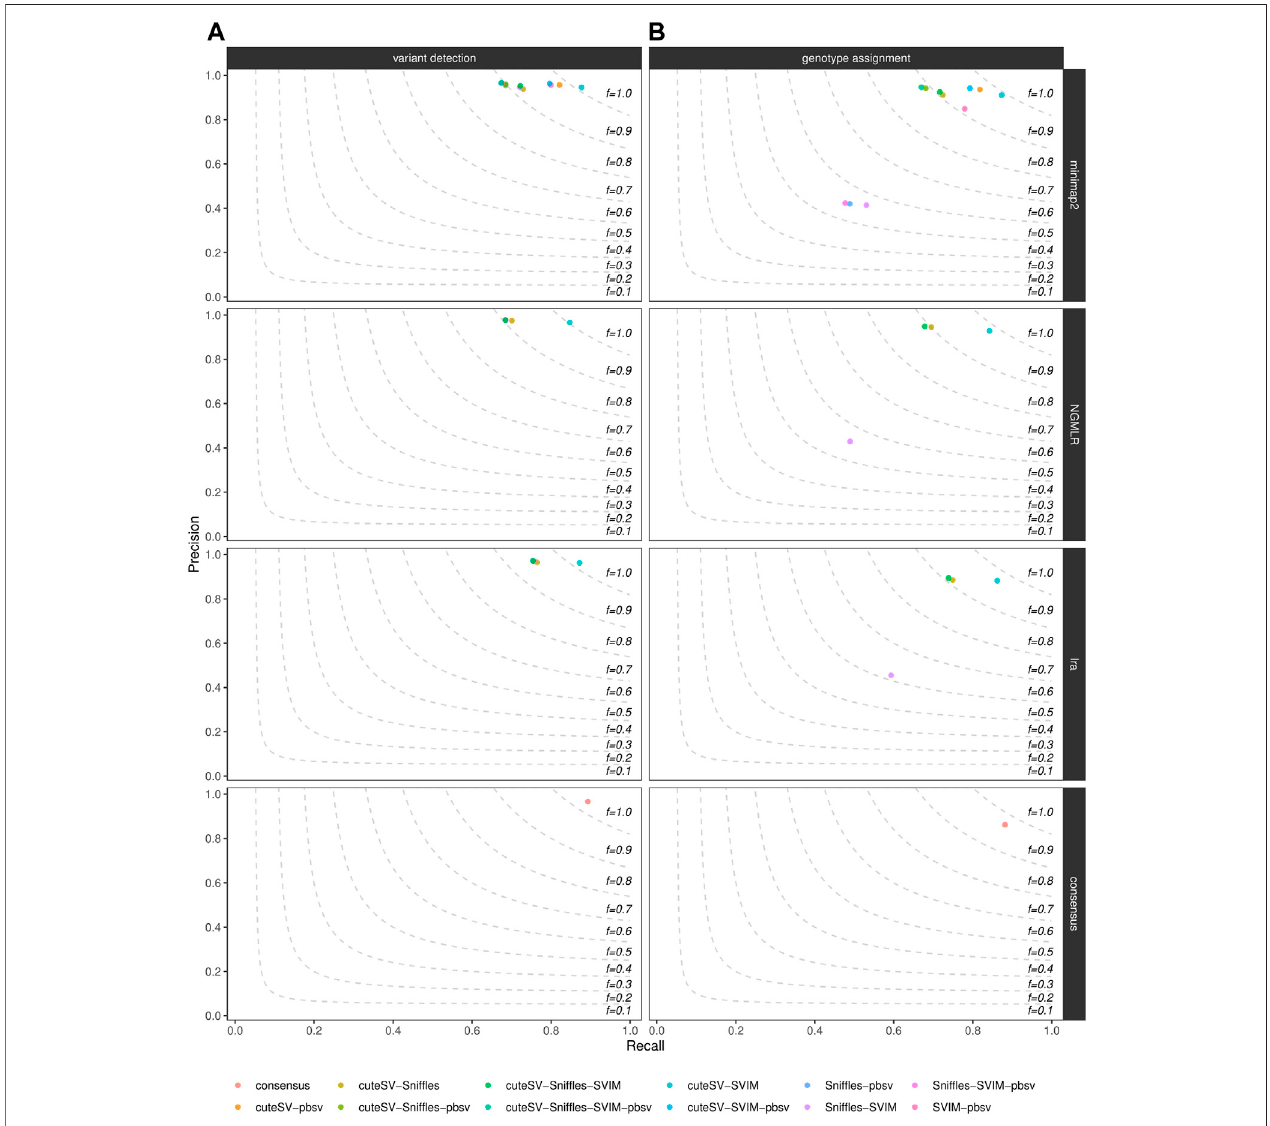
FIGURE 4 | Precision (y axis), recall (x axis) and F-score (dashed lines) of the combination of the SV callers Snif fl es, SVIM, cuteSV and pbsv (hue palette) after minimap2,NGMLRandlraalignmentsaswellasafterconsensusgeneration(top-to-bottompanels).ResultsforbothSVcalling(leftpanels)andgenotyping(rightpanels) are reported. The plot shows the in fl uence of the integration of multiple high-quality callsets on reducing false positive calls in the NA24385